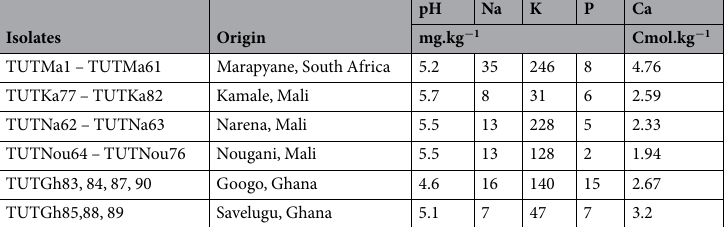
Table 1. Geographic origin of isolates and the soil chemical properties of sampling locations.